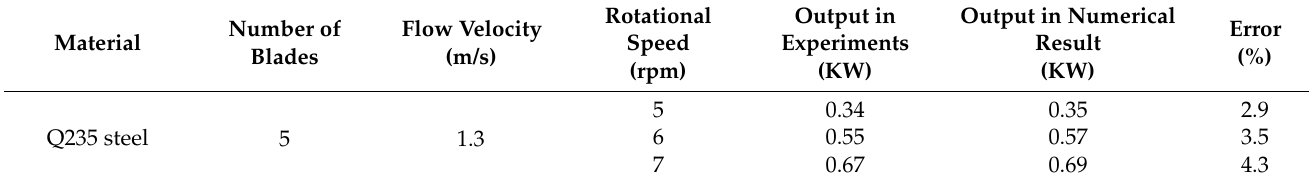
Table 2. Experiment and numerical simulation results in a clearance configuration of 86 mm.